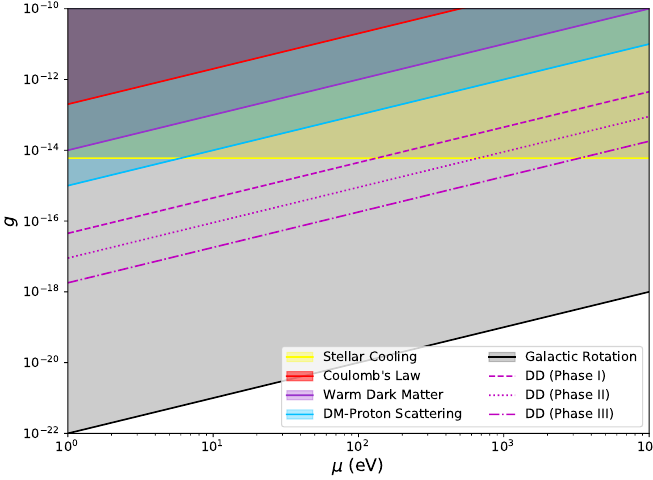
Figure 3 . Bounds on the direct coupling g of the millicharged χ field to the photon as a function of µ , as well as the projected reaches of a direct deflection experiment for the three sets of parameters discussed in [10]. Note that there is considerable uncertainty in the galactic spin-down bound; see [54]. Bounds and projected sensitivities for direct detection lie outside of the plotted region, at larger masses [48,